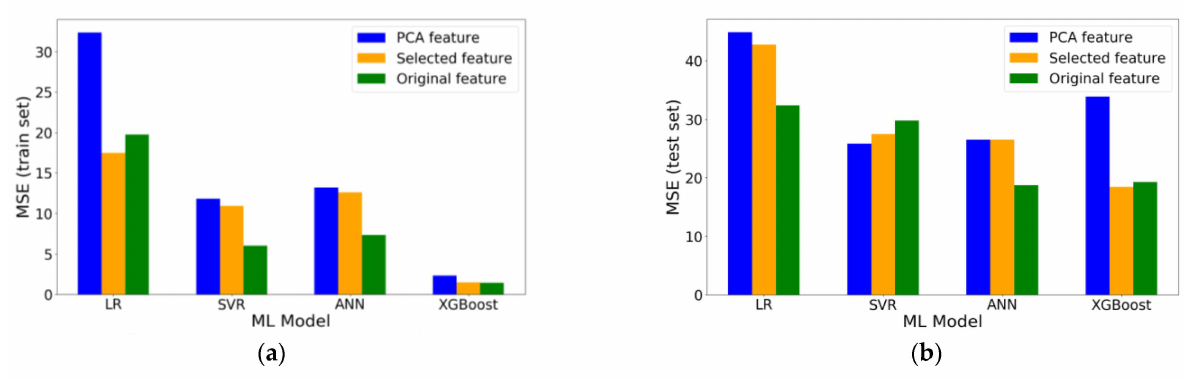
Figure 16. MSE of different ML models with different features: ( a ) training set and ( b ) test